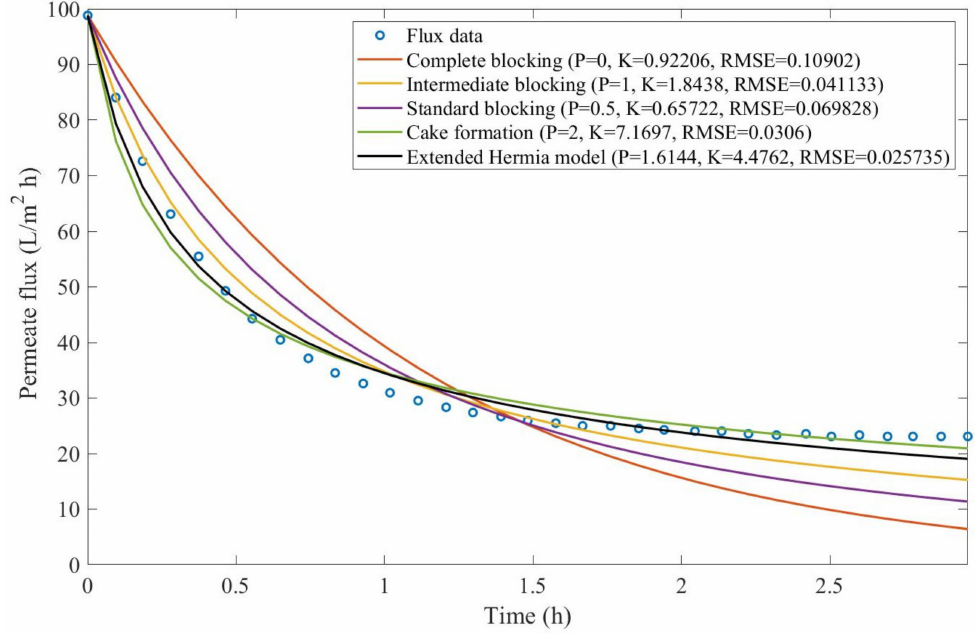
Figure A13. Model fitting for corn syrup microfiltration with CM05 at 2.31 m/s and 51.71 kPa considering the four original pore-blocking mechanisms and the extended Hermia model